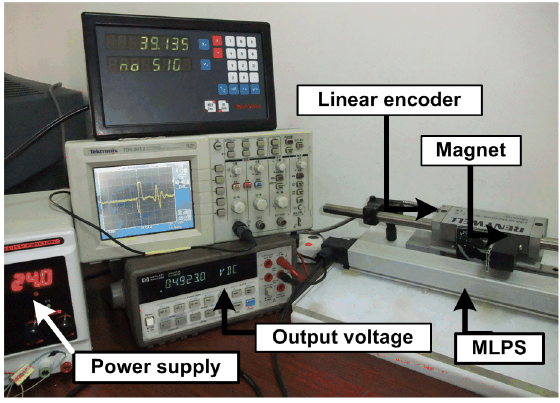
Figure 7. Experimental setup.